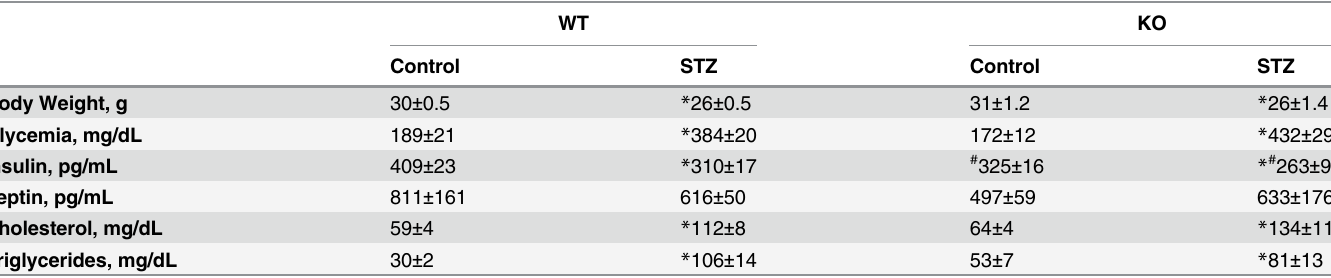
Table 1. Basic Physiological Parameters.